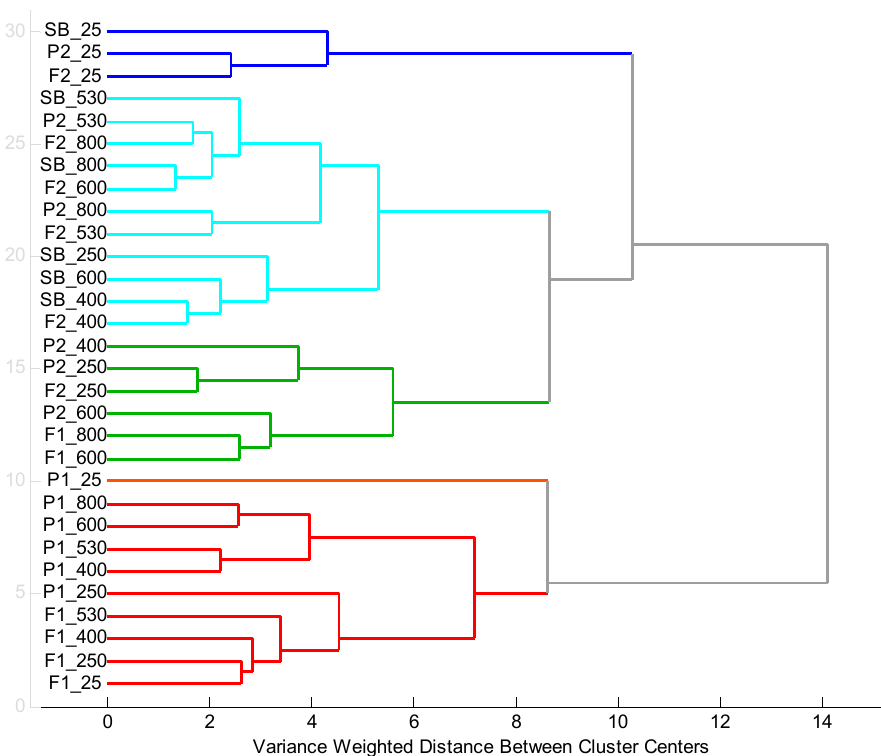
Figure 3. HCA (Hierarchical Agglomerative Analysis) performed in Matlab. Ward’s method and Euclidean distance. The colors indicate the different clusters with variance weighted distance < 10. Labels: Site_HeatingTemperature. Unburned samples have “_25” in their label. F1—forest 1, F2—forest 2, P1—pasture 1, P2—pasture 2, SB—slash-and-burn. Two main groups are observed: F1 and P1, and F2, P2 and SB.